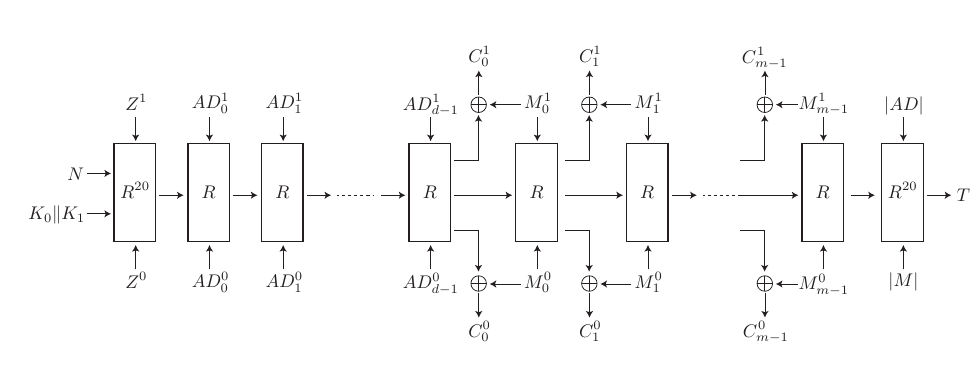
Figure 2: The encryption procedure of Rocca